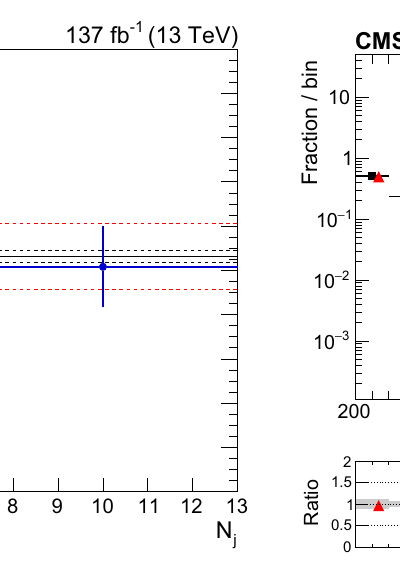
Z → ν ¯ ν simulation compared to the one obtained from the Z → (cid:8) + (cid:8) − data control sample, in a region with 1200 < H T < 1500 GeV and N j ≥ 2, inclusive in N b . The solid gray band on the ratio plot shows the systematic uncertainty in the M T2 shape. The bins have different widths, denoted by the horizontal bars